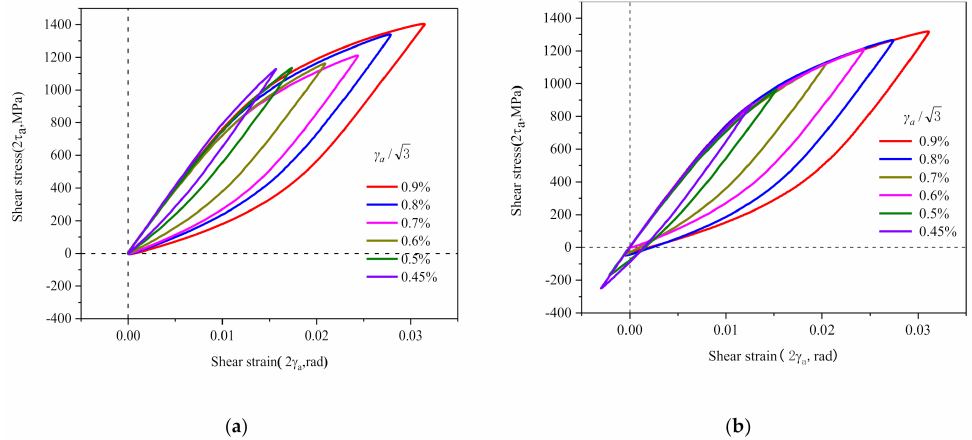
Figure 5. The half-life hysteresis loops for different shear strain amplitudes: ( a ) the lower tips of all hysteresis loops from different strain amplitudes are transferred to a common origin (0, 0); ( b ) translating along the linear elastic